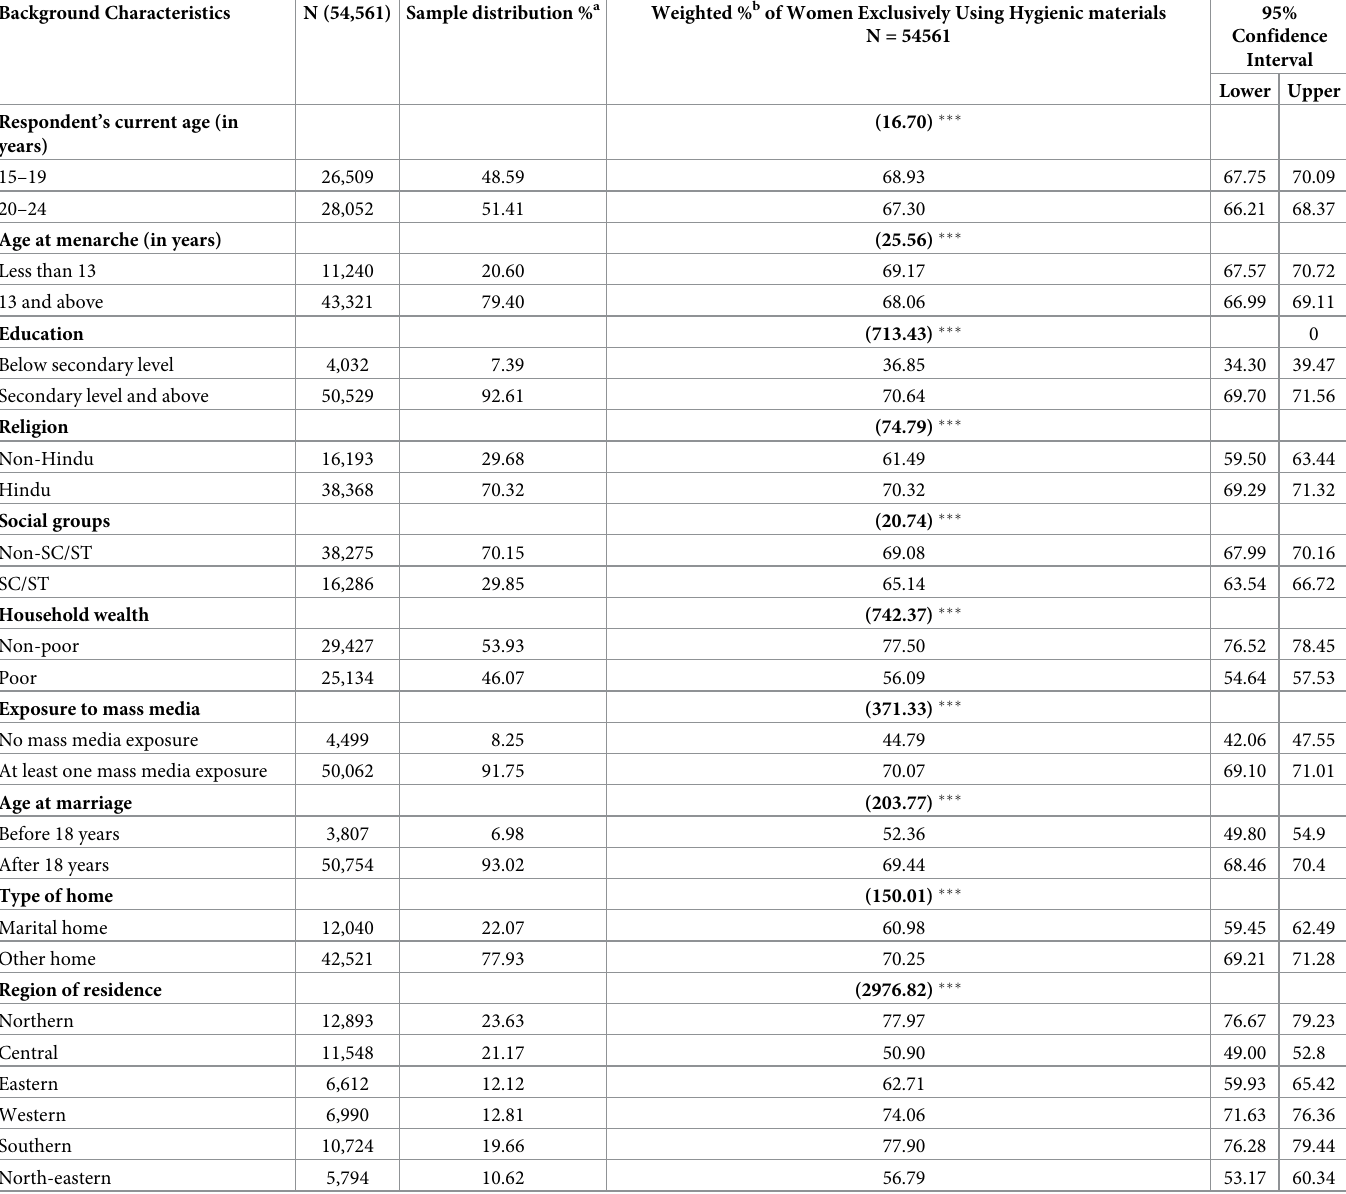
Table 2. Descriptive statistics of sampled urban women aged 15–24 years, and percentage of women using hygienic materials exclusively by background characteris- tics, NFHS-5, 2019–21. Background